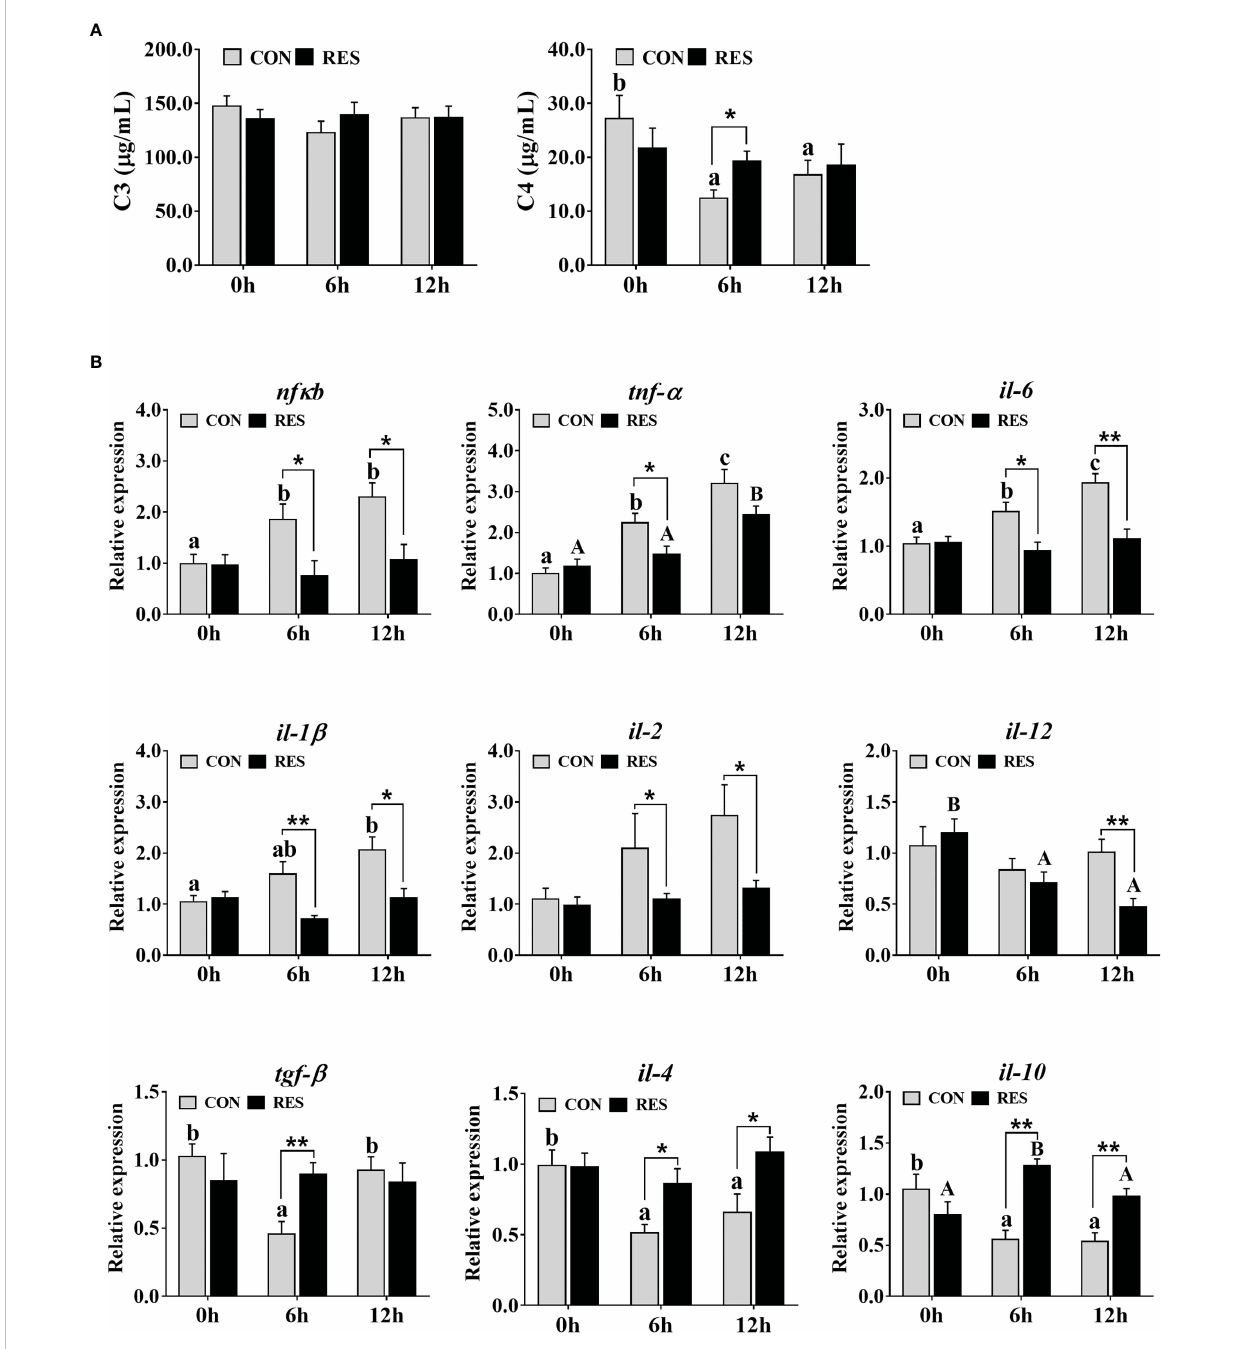
FIGURE 6 Effect of dietary RES on immune reaction in plasma (A) and mRNA expression levels of in fl ammation-related genes in the liver (B) of gibel carp at 6 h and 12 h after LPS injection. The lowercase letters represent signi fi cant differences among diverse LPS durations in the CON group ( P < 0.05); the uppercase letters represent signi fi cant differences among diverse LPS durations in the RES group ( P < 0.05). *( P < 0.05) and **( P < 0.01) represent signi fi cant differences between the CON and RES groups. Nf k b , nuclear factor- k B; tnf- a , tumor necrosis factor a ; il-6 , interleukin-6; il-1 b , interleukin-1 b ; il-2 , interleukin-2; il-12 , interleukin-12; tgf- b , transforming growth factor b ; il-4 , interleukin-4; il-10 ,